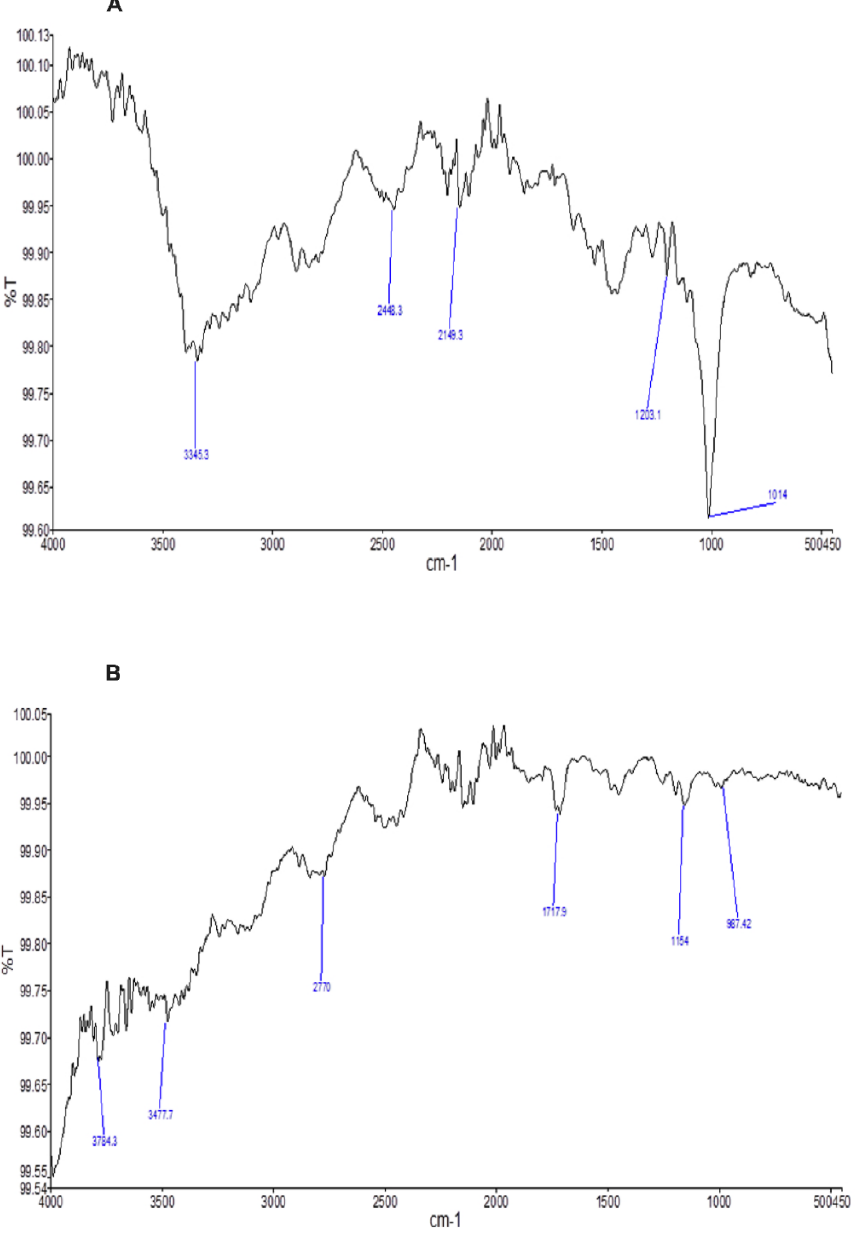
Figure 2. Graphical representation of ( A ) esomeprazole and ( B ) formulation F1 formulation FTIR spectra.